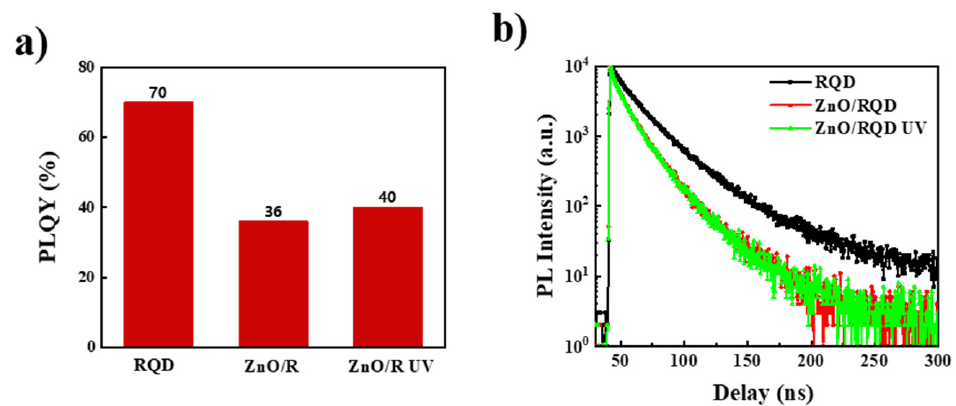
Figure 4. PLQY ( a ) and TRPL lifetime ( b ) of samples quartz/QDs, quartz/ZnO/QDs, and quartz/ZnO/QDs with UV irradiation.